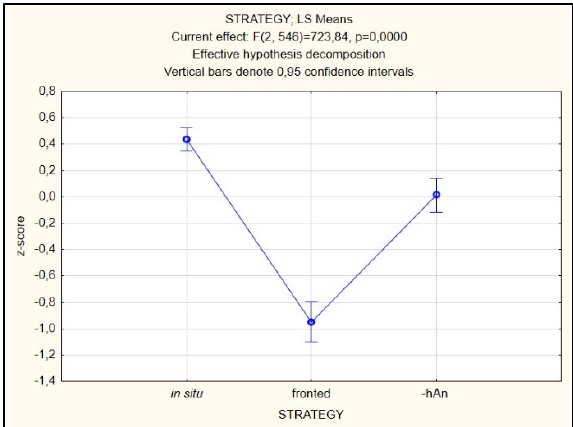
Figure 7. Strategy mean results (Finnish) .